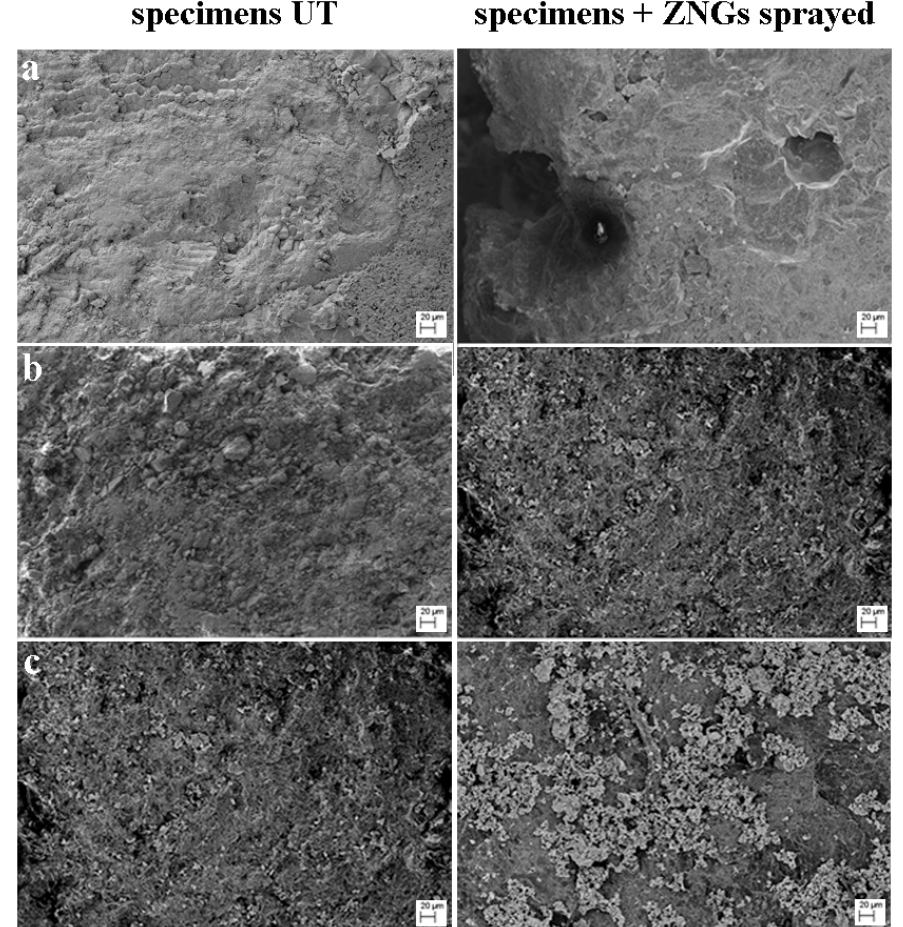
Figure 5. FE-SEM images of different untreated and sprayed with ZNGs 250 µg/mL specimens. ( a – c ) indicate Noto stone, Common yellow brick and Carrara marble, respectively.